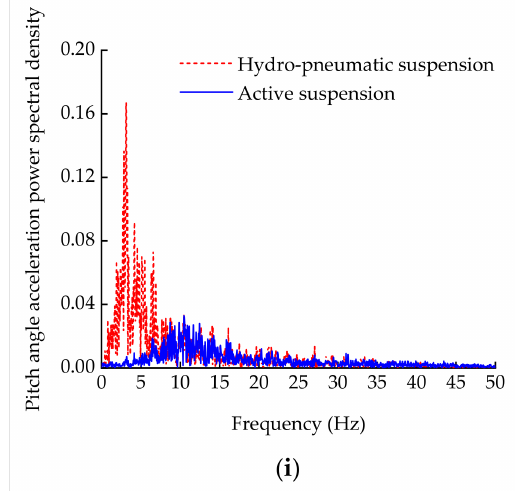
Figure 13. Attitude, acceleration of vehicle body and power spectral density of each acceleration: ( a ) vertical displacement of vehicle body; ( b ) roll angle of vehicle body; ( c ) pitch angle of vehicle body; ( d ) vertical acceleration of vehicle body; ( e ) roll angle acceleration of vehicle body; ( f ) pitch angle acceleration of vehicle body; ( g ) vertical acceleration power spectral density; ( h ) roll angle acceleration power spectral density; ( i ) pitch angle acceleration power spectral density.